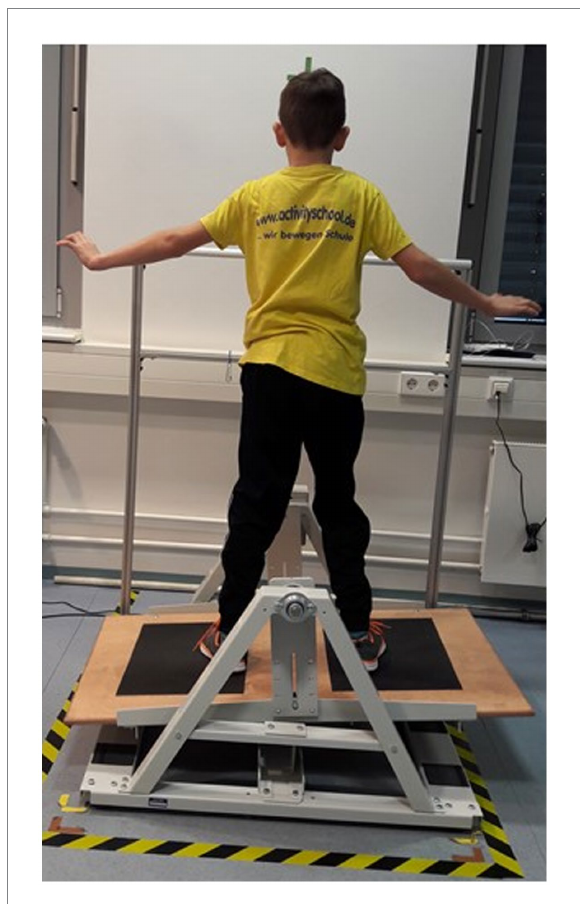
FIGURE 1 Illustration of a participants balancing on the stability platform (stabilometer). Participant’s assent and parents’ written informed consent were obtained to publish this